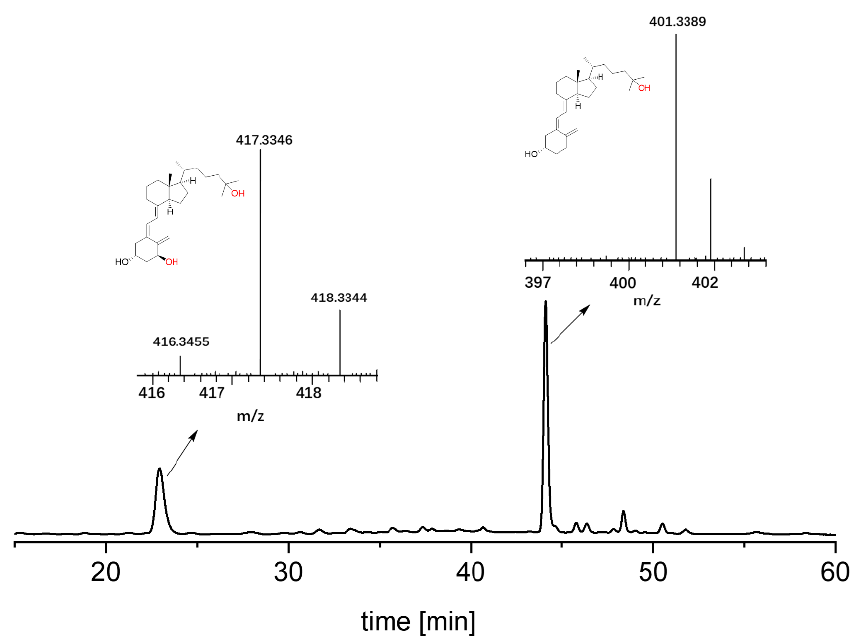
Figure 4. HPLC chromatograms and LC – MS data of the synthesis of calcitriol starting from vitamin D3. LC – MS chart of product calcitriol with mass spectrum displayed in [M + H] + . Retention time at 22.88 and 44.06 min represents calcitriol and 25-hydroxyvitamin D3, respectively. The retention time of vitamin D3 longer than 100 min is not shown.